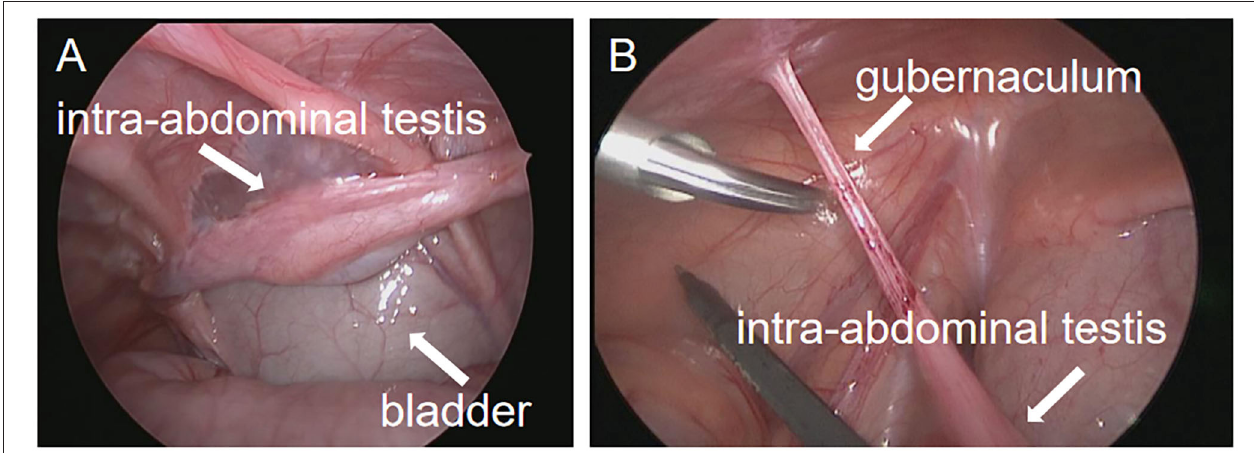
FIGURE 2 | Operation images from second stage exploration in the Shehata technique. (A) In the second stage, the testicular spermatic vessels adhered to the bladder. (B) In the second stage, the gubernaculum of the testis was elongated.